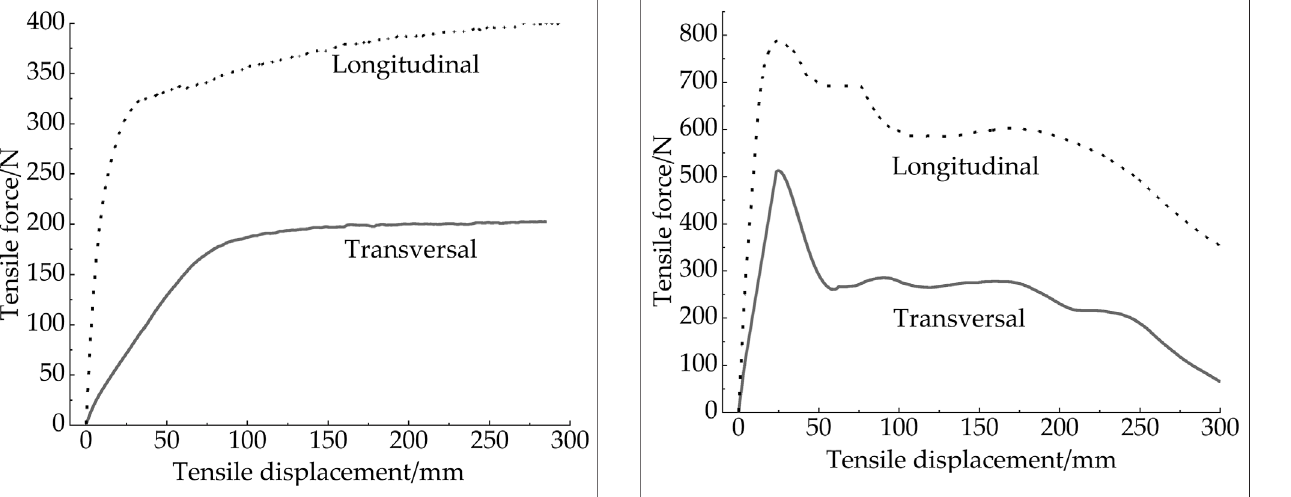
FIGURE 4 | Force curve of HDPE GN1 in two directions.